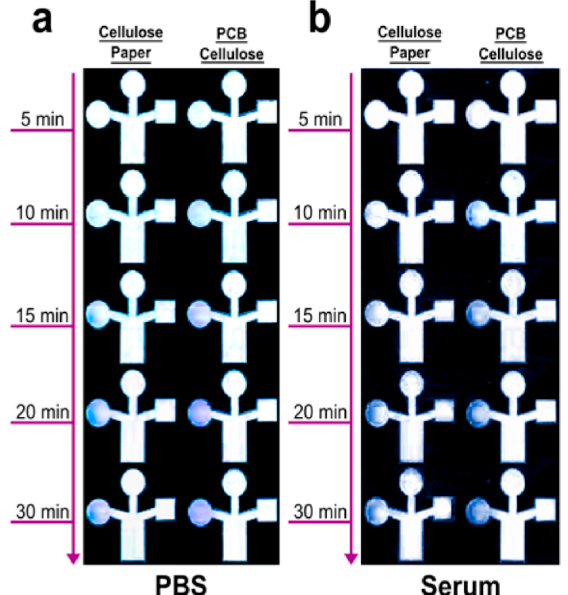
Figure 14. Glucose detection as a function of time using PCB modified and unmodified cellulose paper-based analytical devices. Glucose was spiked (5.0 mM) into ( a ) PBS; and ( b ) undiluted human serum [118].